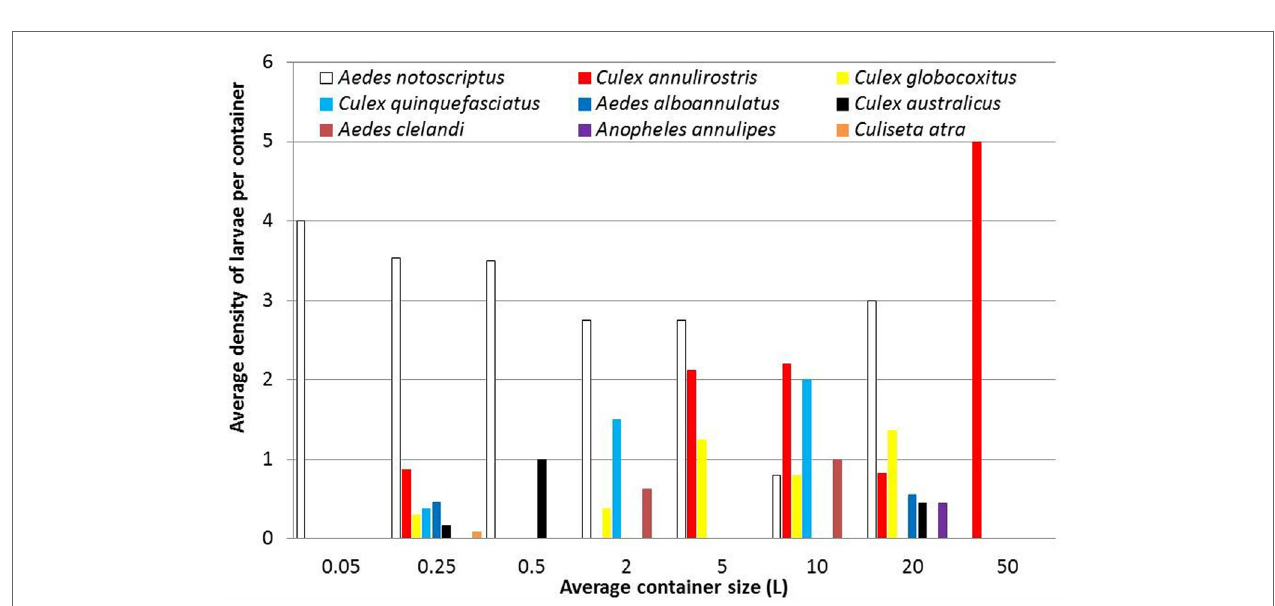
FigUre 6 | The average density of mosquito larvae collected from backyard containers, including 0.05 L (water holding plants); 0.25 L (pot plant bases); 0.5 L (pet water bowls); 2 L (used tires); 5 L (Bird baths); 10 L (watering cans); 20 L (buckets); and 50 L (water